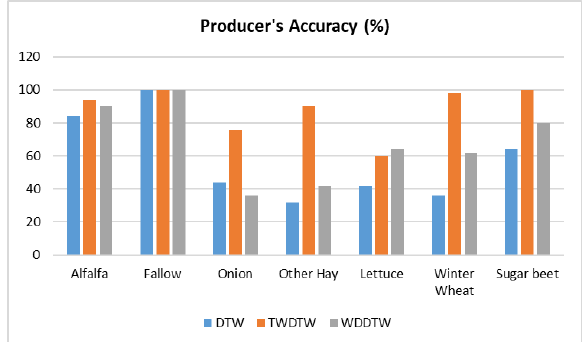
Figure 4. Producer’s accuracy obtained by applying DTW- Dynamic Time Warping, TWDTW- Time Weighted Dynamic Time Warping, WDDTW- Weighted Derivative